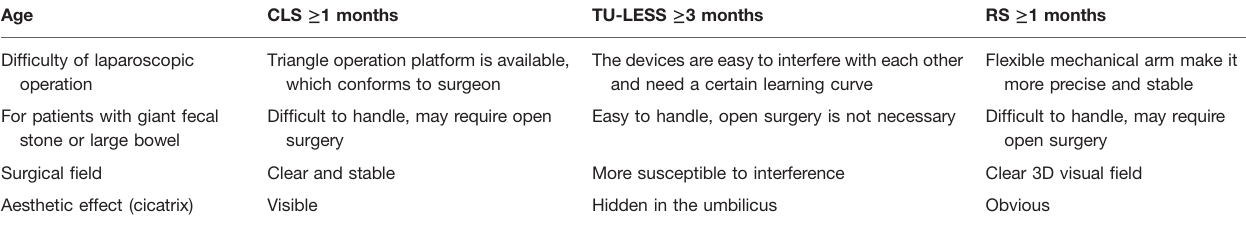
TABLE 5 | Comparison of indications and technical characteristics of three surgical